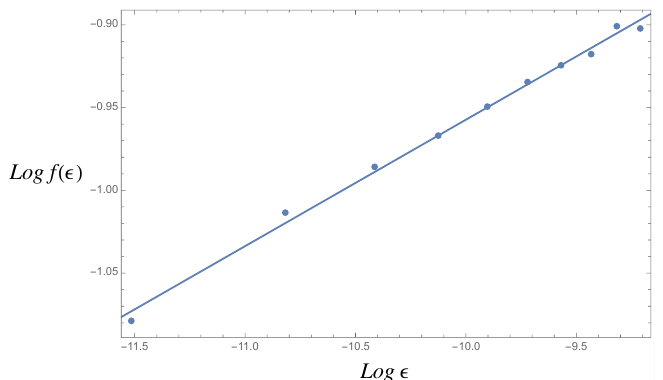
Figure 5 . The uncertain fraction with h = 50 . The axes are given by the natural logarithms. In this paper, we refer to the uncertain dimension d